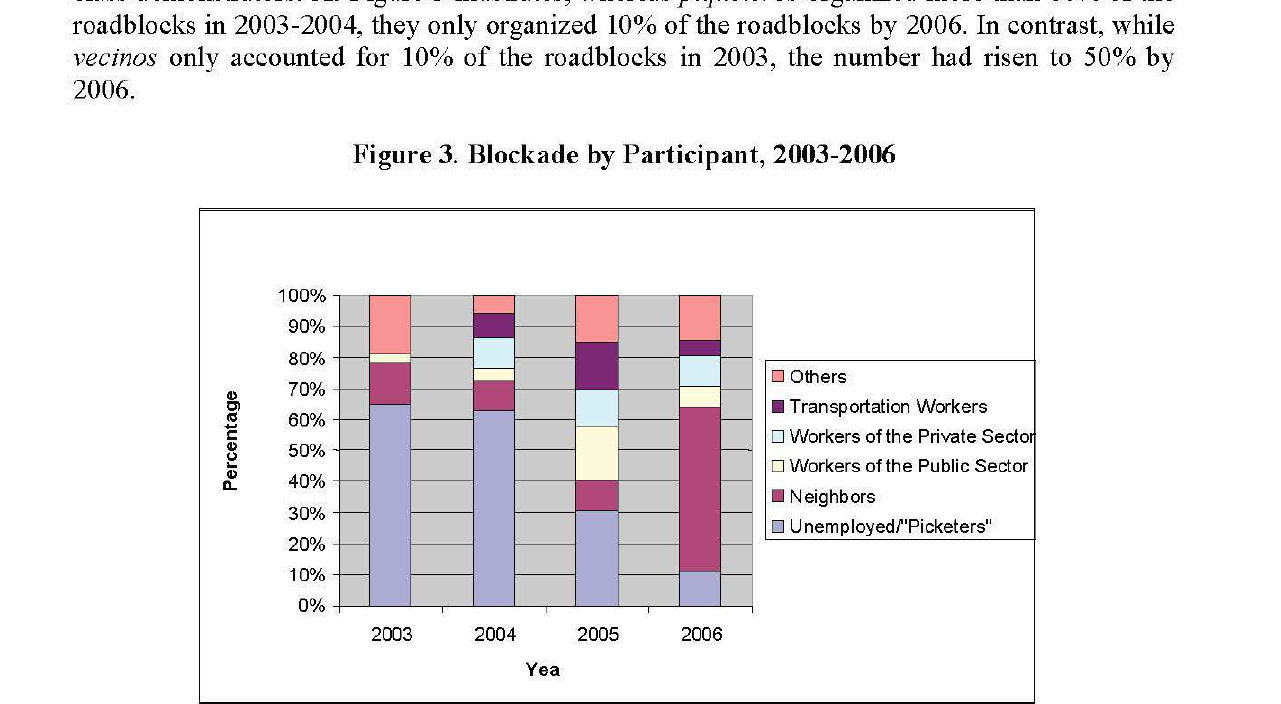
Figure 3. Blockade by